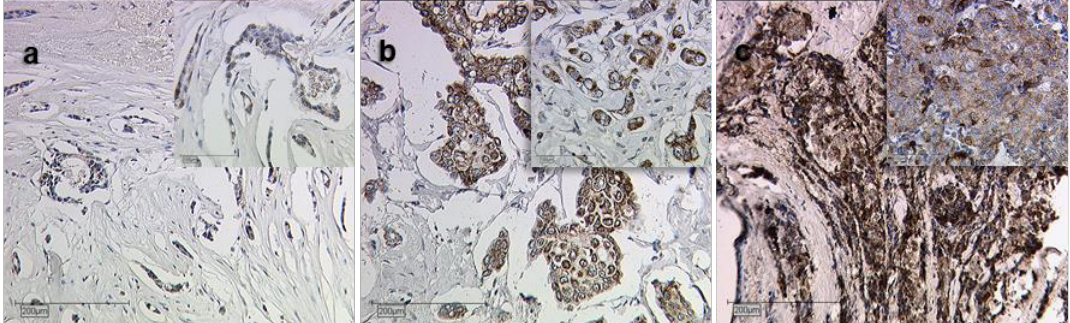
Figure 1. Association of Siglec-8 expression with histopathological subtype and tumor grading. Boxplots of the mean Siglec-8 IRS ± standard deviation (SD) dependent on histopathological sub- type ( a ) and tumor grading ( b ) are shown. ( a ) In non-NST tumors, Siglec-8 expression is signifi- cantly lower than in NST tumors. ( b ) Tumors with G2/3 grading show a significantly higher Sig- lec-8 expression compared to G1 tumors. NST = no special type. IRS = immune reactivity score. SD = standard deviation. G = grading. ** indicates a p -value < 0.01.